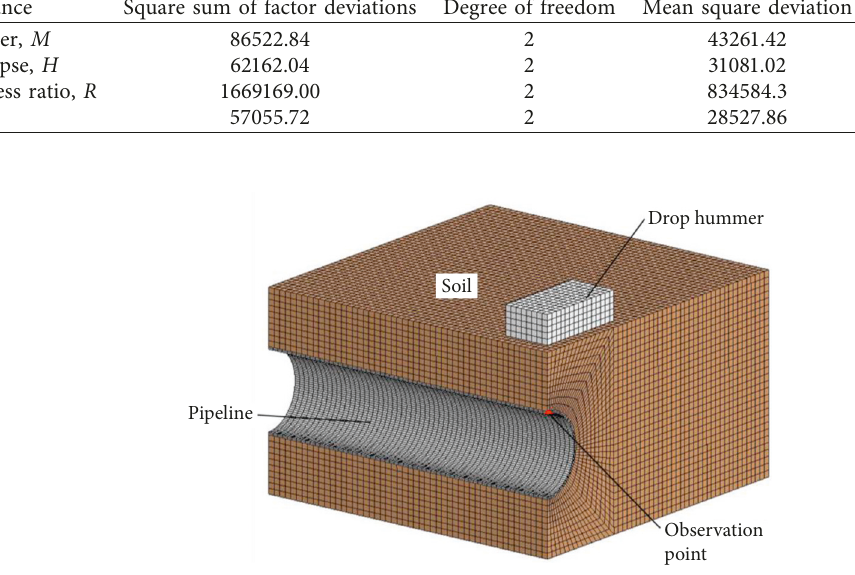
Figure 6: Numerical calculation